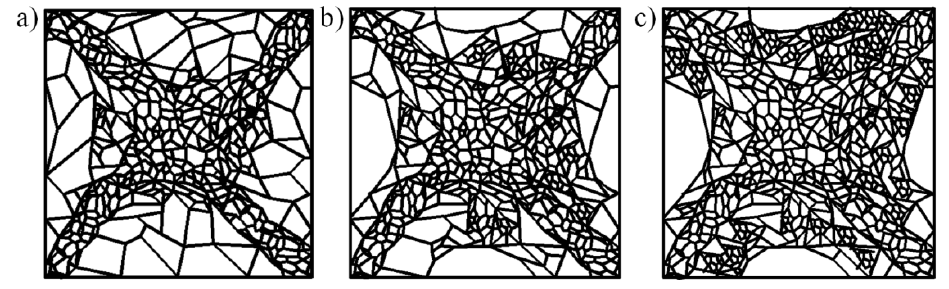
Figure 8. Internal grain size evolution of double-open MDF: ( a ) 3, ( b ) 6, and ( c ) 9 passes.